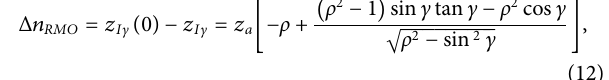
particular location ( x Is , z I ) and ( x Ir , z I ) in the subsurface (as purple dashed circles indicate) after migration, respectively. By correlating the two wave fi elds, the anti-causal crosstalk will be generated.